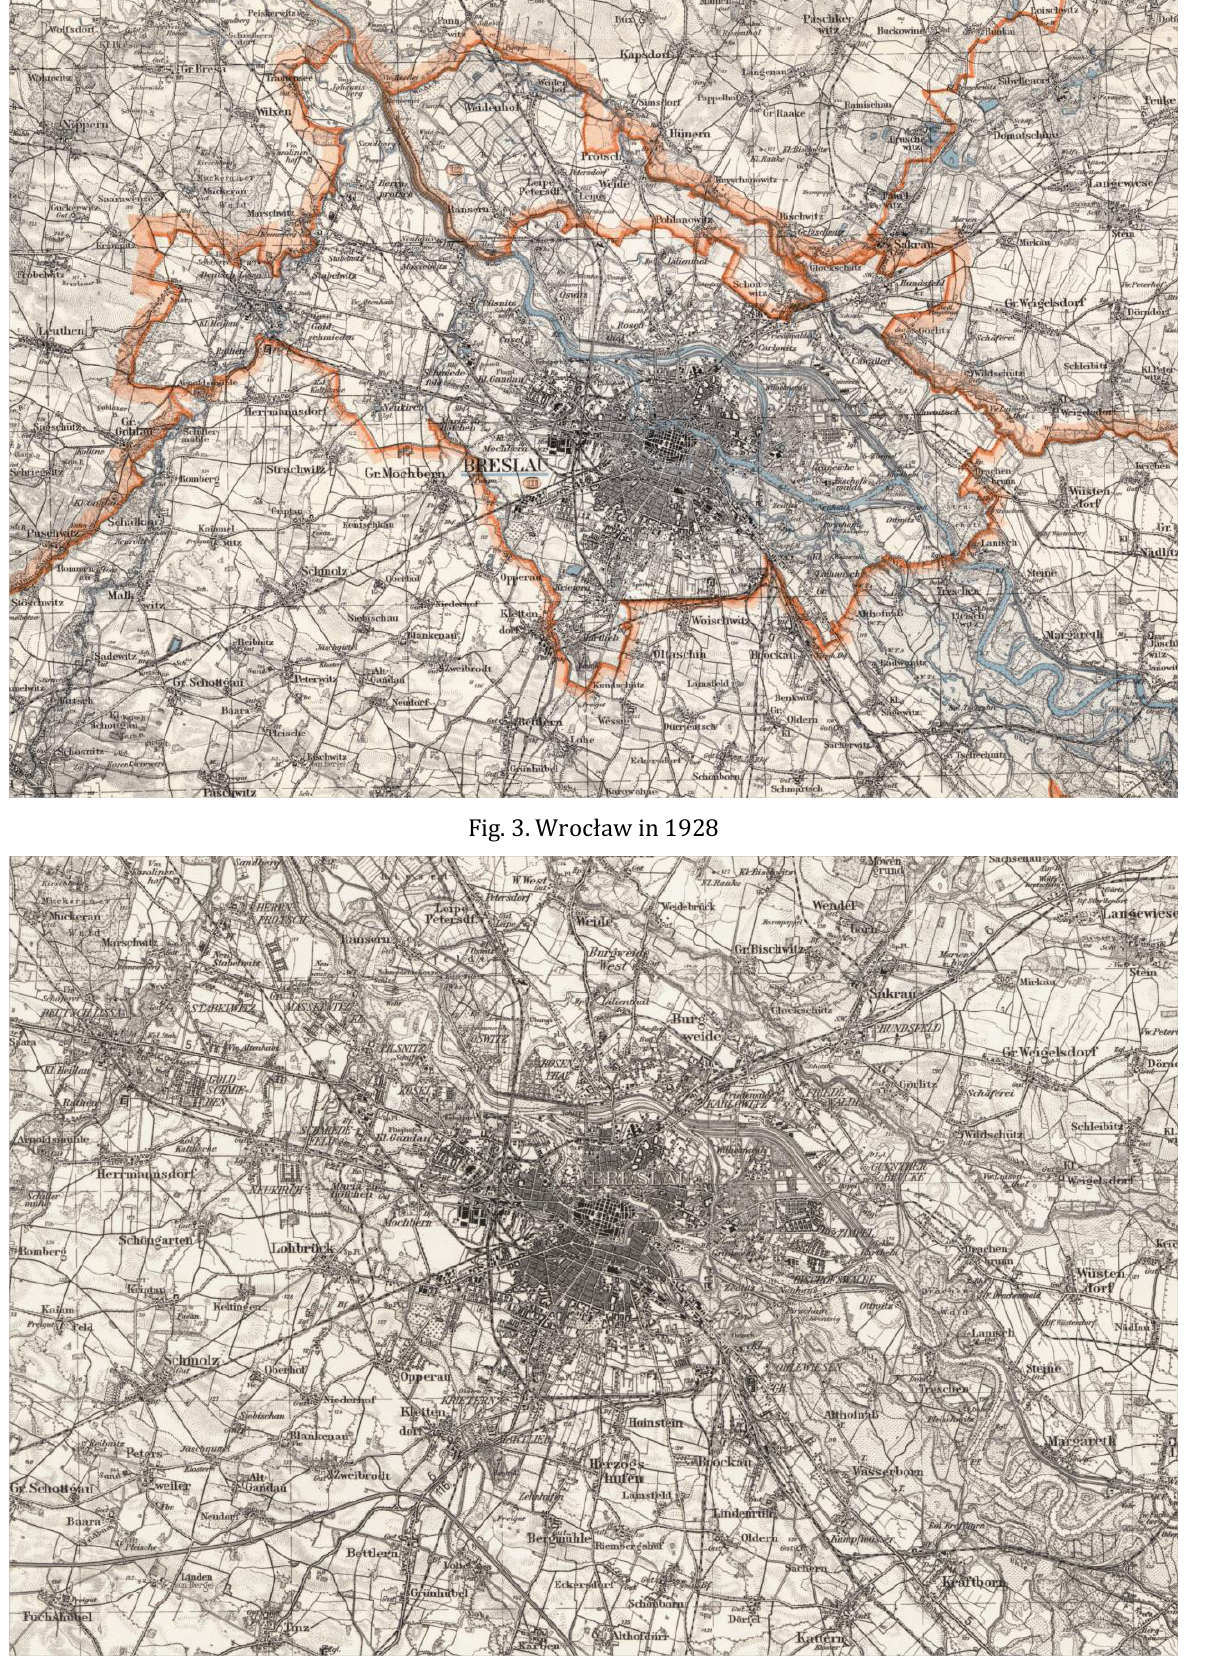
Fig. 4. Wrocław district in